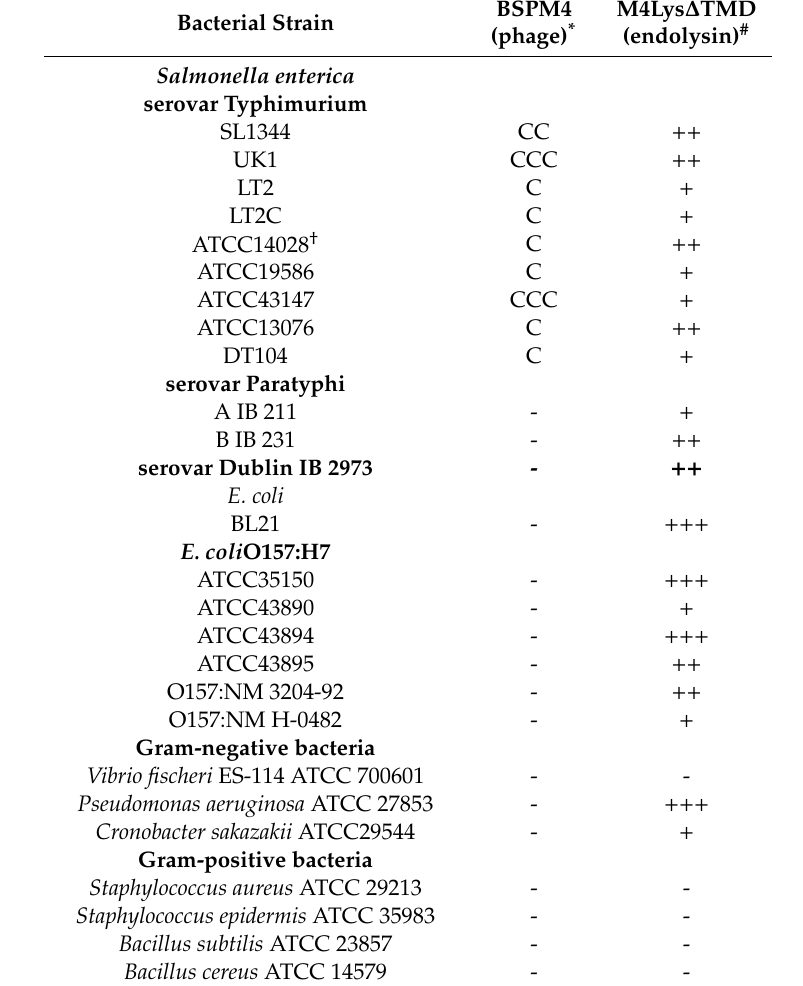
Table 3. Determination of host range of BSPM4 bacteriophage and its